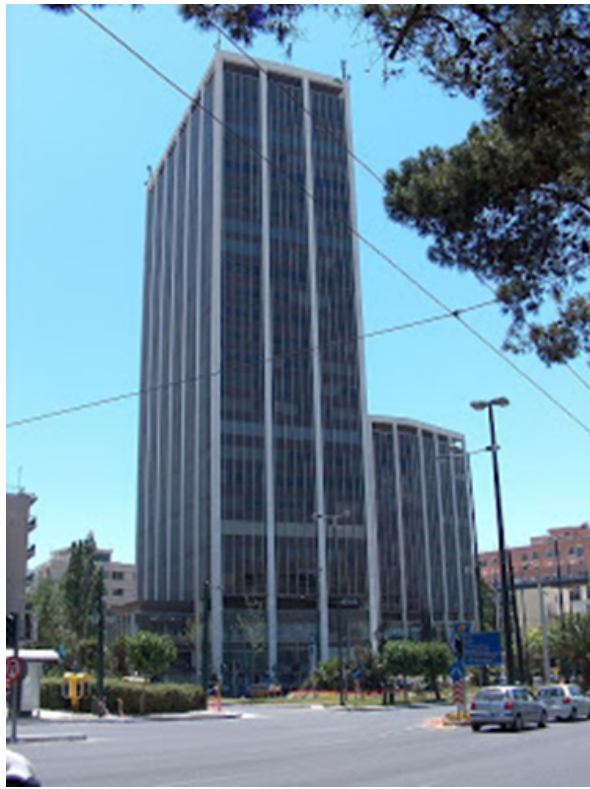
Figure 7: External view of the “Tower of Athens”